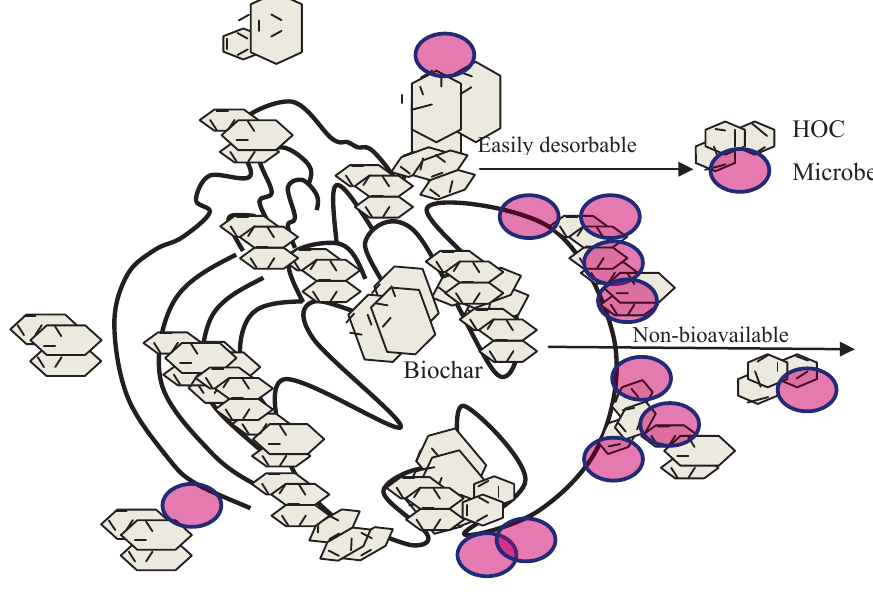
Figure 2. Description of HOC availability to microorganisms. Adapted from